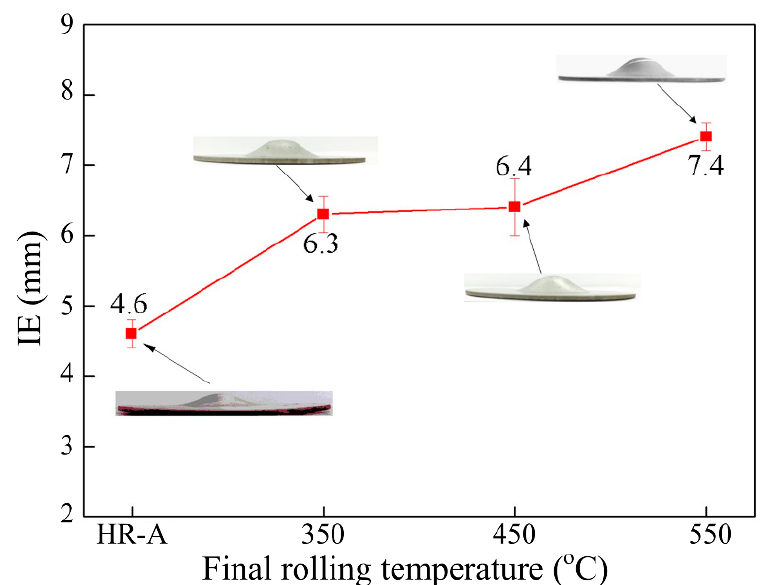
Figure 9. Erichsen values (IE) of HR-A sample and various ECAR-CB-A samples at different final rolling temperatures.